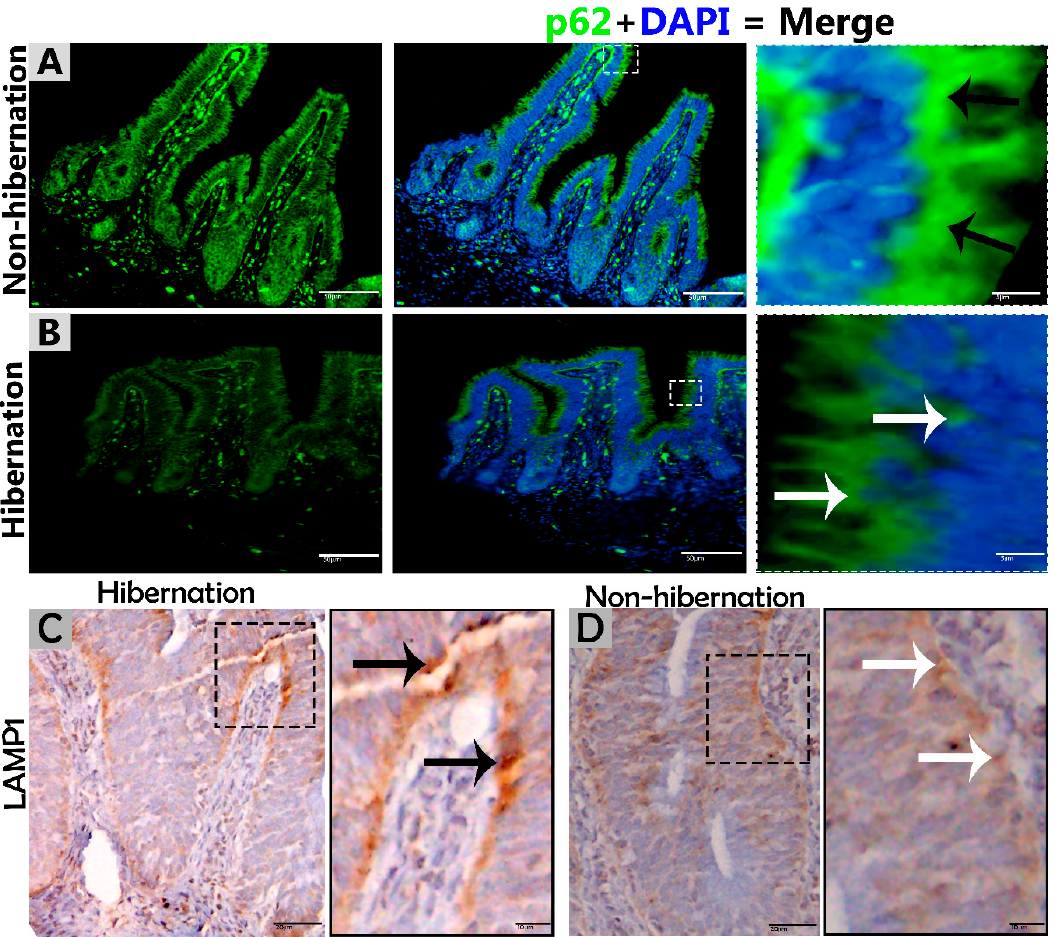
Figure 3. Immunofluorescence staining of p62 and immunohistochemistry of LAMP1 in the mucosal surface of the small intestine of P. sinensis. During hibernation ( B , C ) and nonhibernation ( A , D ), there were strong, positive (black arrow) and weak expressions (white arrow). Scale bar = 50 µm ( A , B ) and 20 µm ( C , D ).